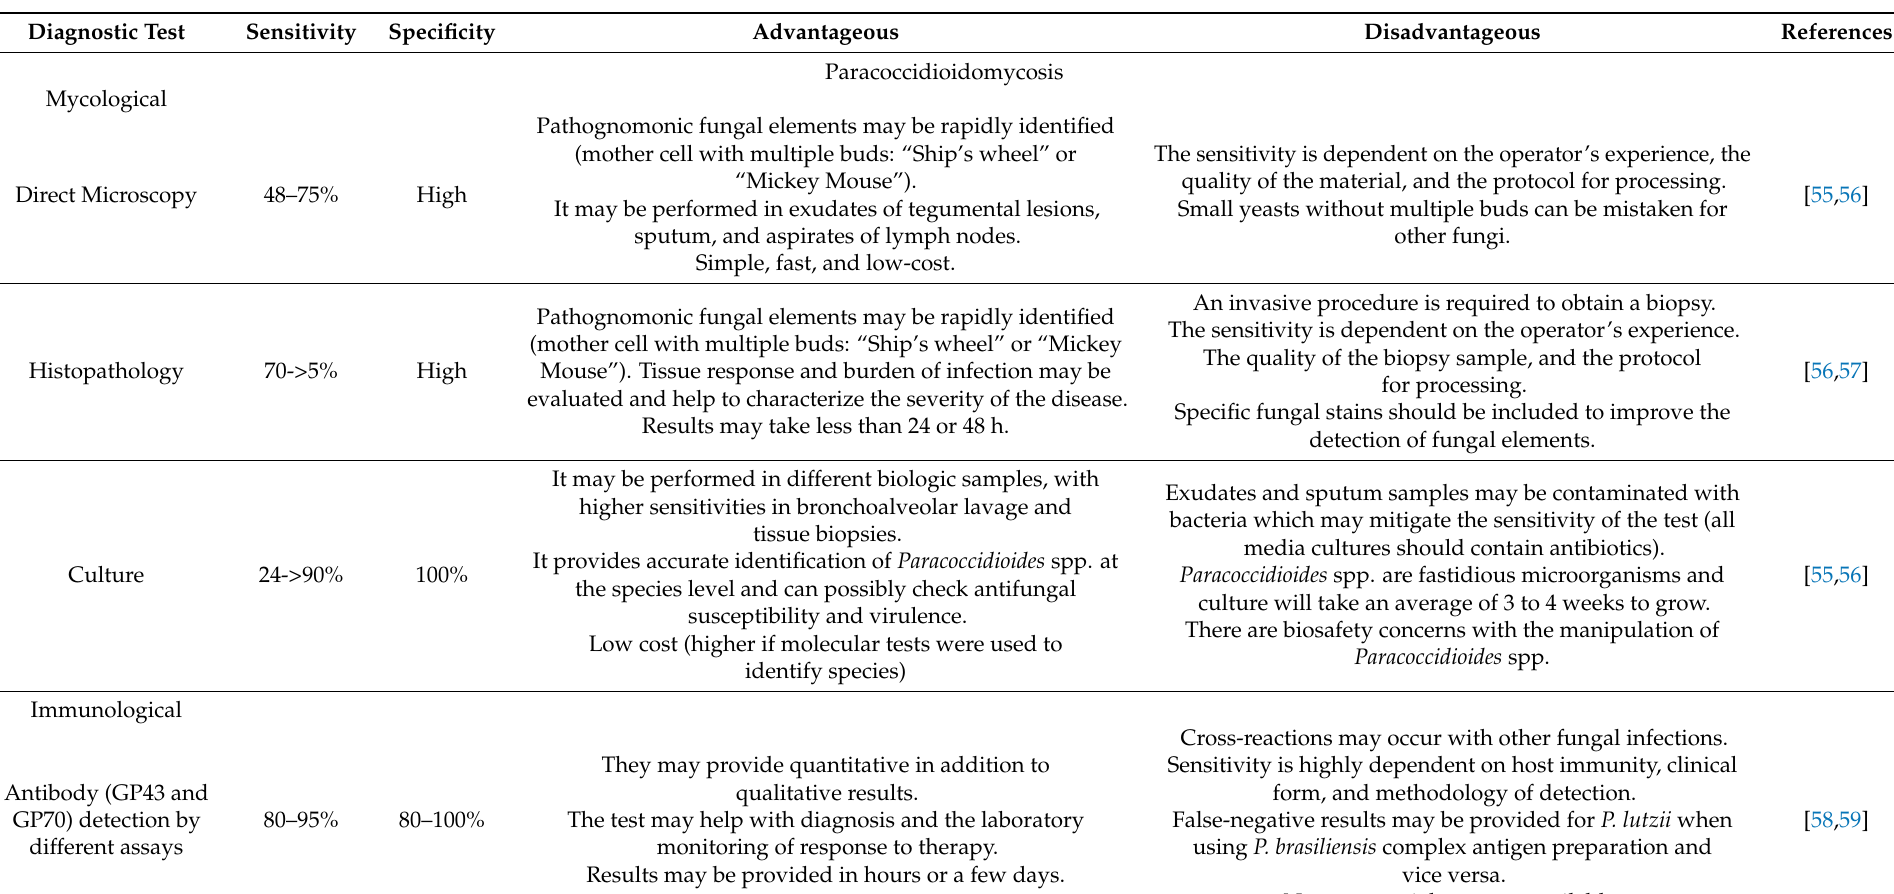
Table 1. The sensitivity, specificity, advantages, and disadvantages of all diagnostic methods for Paracoccidioidomycosis and